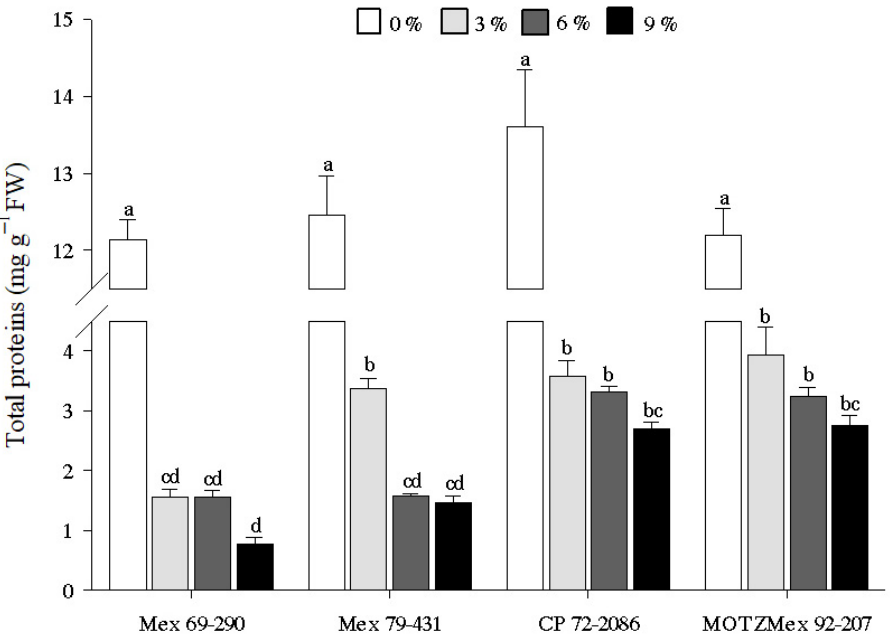
Figure 2. Effect of different concentrations of PEG-6000 on total protein content in sugarcane cultivars ( Saccharum spp. Hybrids). Bars above the columns represent the standard error. Different letters above the columns of each subfigure indicate significant statistical differences among treatments (Tukey, p ≤ 0.05).